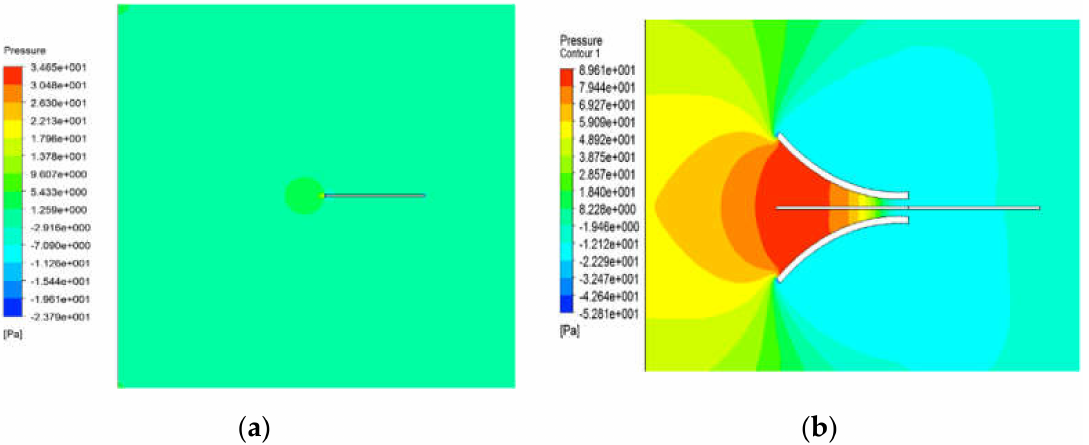
Figure 3. Pressure distribution by numerical simulation: ( a ) without FTEH; ( b ) with